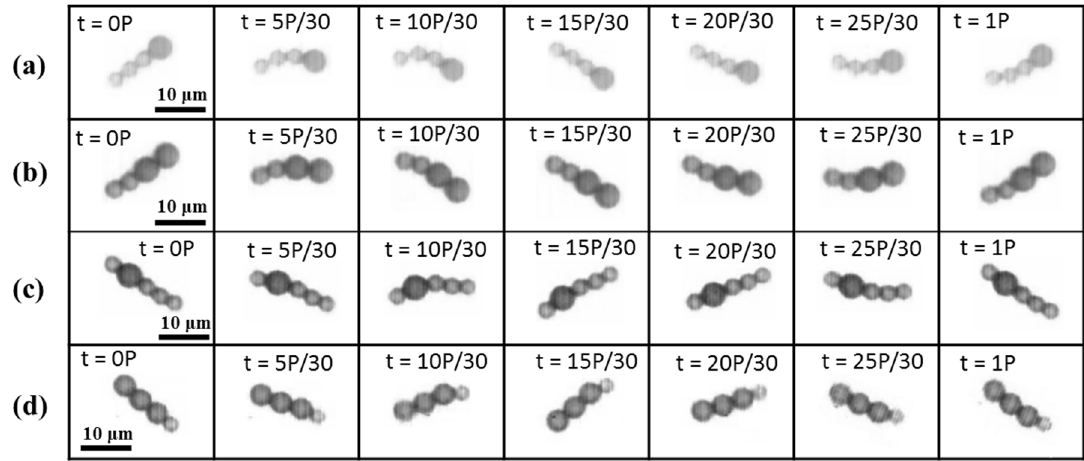
Figure 2. The evolution of the distortion of the ( a ) L1S3, ( b ) L2S2, ( c ) S1L1S3, ( d ) L3S1 swimmers in an oscillating field ( H p = 2000 A / m, H d = 1900 A / m, f = 10 Hz). The images were captured within an arbitrary period (denoted as P) of oscillation. All swimmers oscillated clockwise from the top position and anticlockwise when they reached the bottom, and then returned to the initial point.